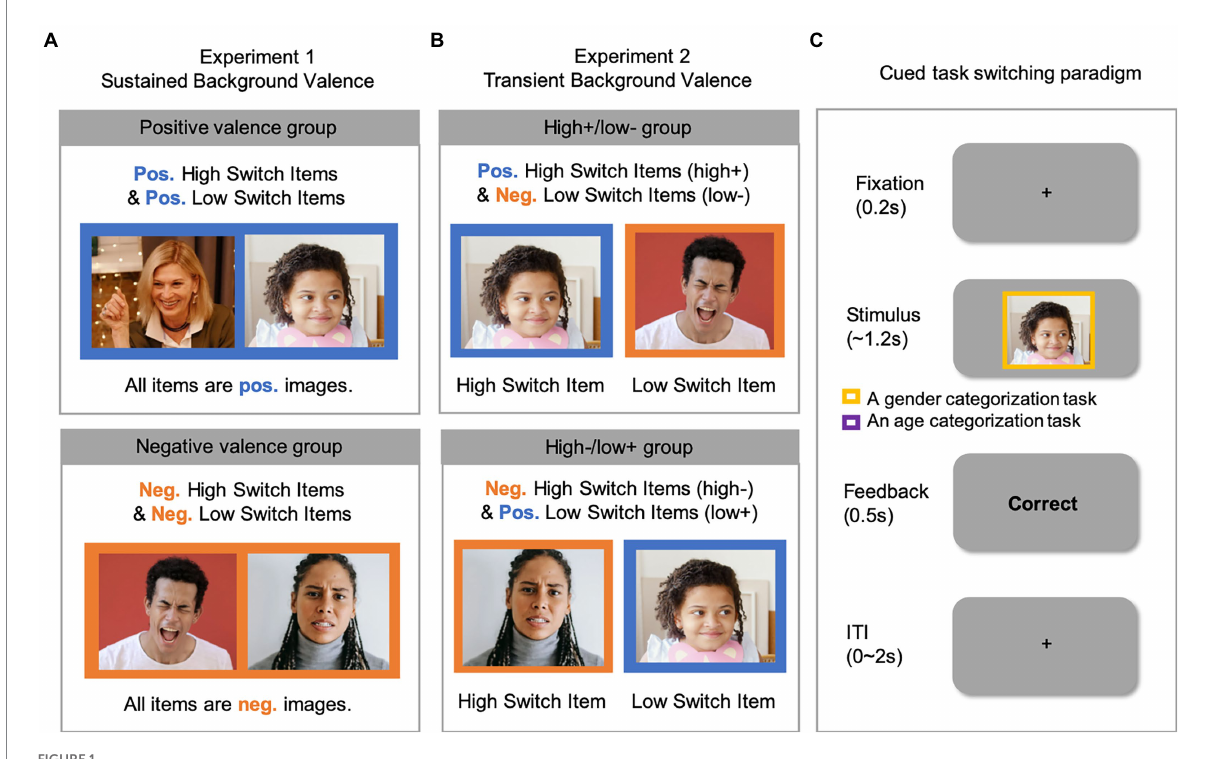
FIGURE 1 The overall background valence manipulation for (A) Experiment 1 and (B) Experiment 2 and (C) an example trial in the cued task-switching paradigm. Note that the images (selected from https://www.pexels.com/) shown in this figure are for illustration purposes only. Please see Method for detailed descriptions regarding the source and the stimulus selection procedure of the images used in the experiment. Neg., Negative valence; Pos., Positive